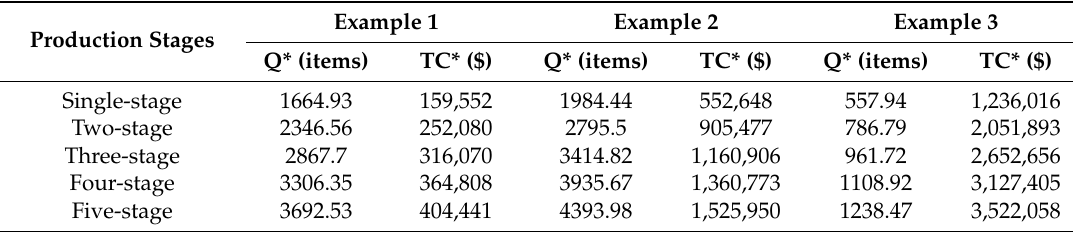
Table 1. Optimal results of the numerical